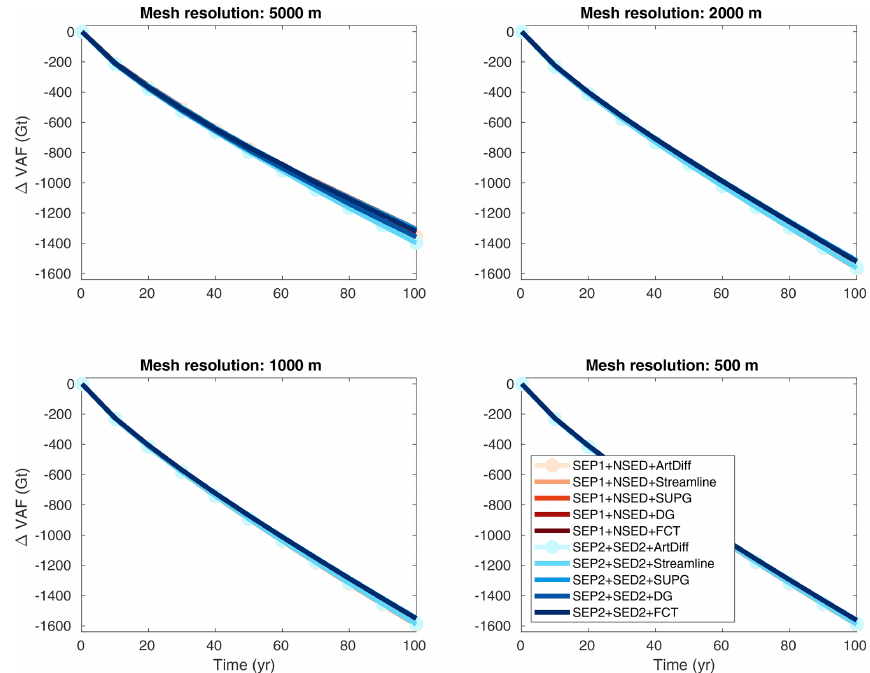
Figure 12. Basal friction perturbation experiment: evolution of (cid:49) VAF for different mesh resolutions and stabilization schemes (see legend). Two sets of sub-element parameterizations are employed: SEP1 + NSED and SEP2 +